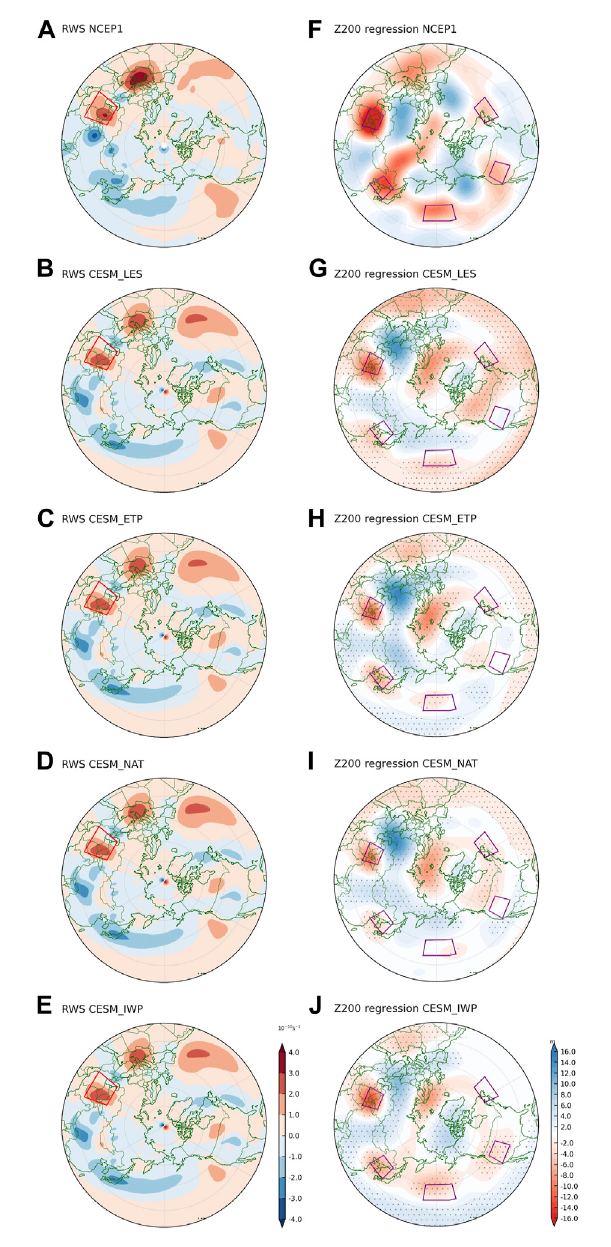
FIGURE 2 The summer mean Rossby wave source (RWS) (A – E) , and the regressionofthe200 hPageopotentialheight(Z200) (F – J) ontheRWS_ CGT index in summer (June — August) and for (A,F) the NCEP one reanalysis, (B,G) the CESM_LES, (C,H) the CESM_ETP, (D,I) the CESM_NAT, and (E,J) the CESM_IWP. The dotted regions in (A – E) indicate the ensemble mean of regression pattern is signi fi cant at the 95%con fi dencelevel.ThepurpleboxesshowtheactioncentersofCGT.